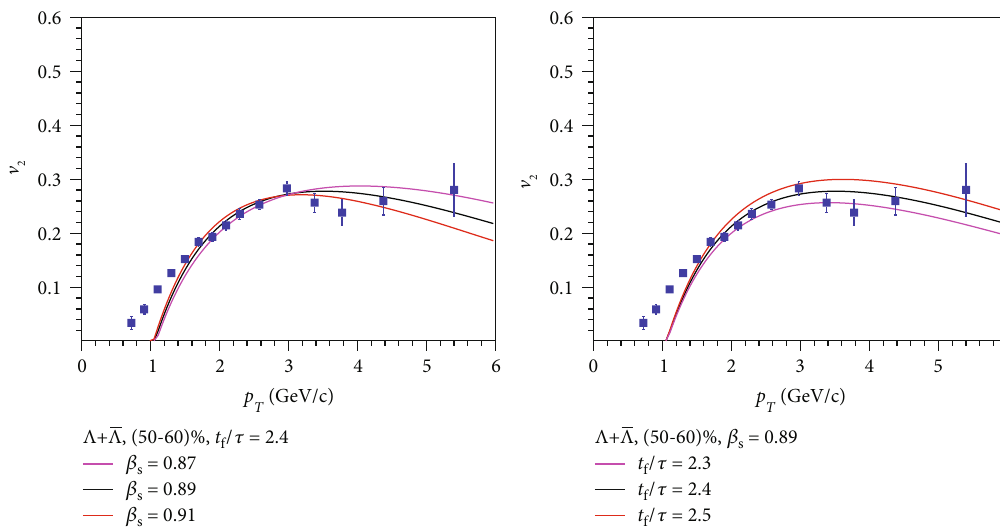
ffiffiffiffiffiffiffiffi p = 2 : 76 TeV . Symbols s NN